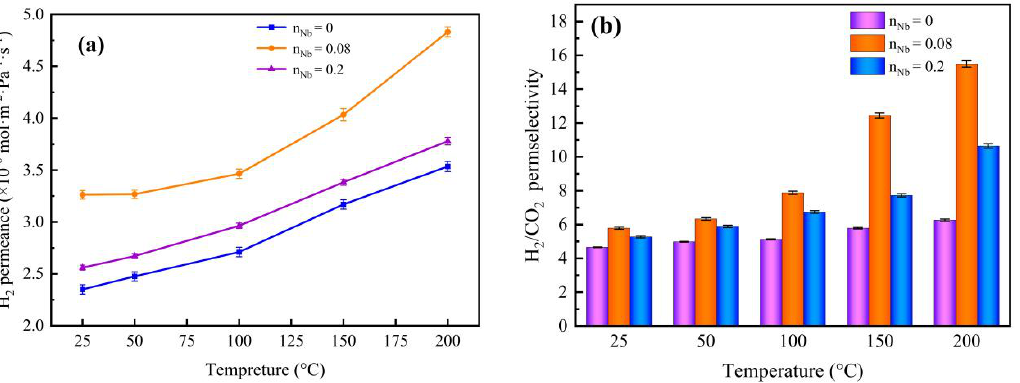
Figure 14. Effect of temperature on ( a ) H 2 permeance and ( b ) H 2 /CO 2 permselectivity of Nb/SiO 2 membranes with different n Nb at a pressure difference of 0.1 MPa.